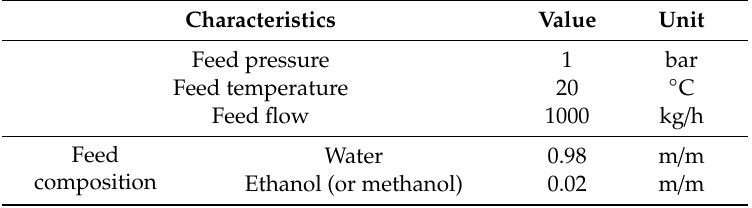
Table 8. Feed characteristics of hydrophilic and organophilic pervaporation membrane